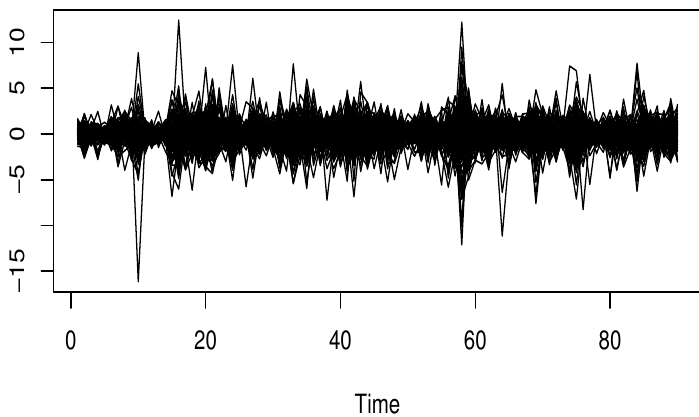
Figure 4. The initial curves; the case when R = 90.